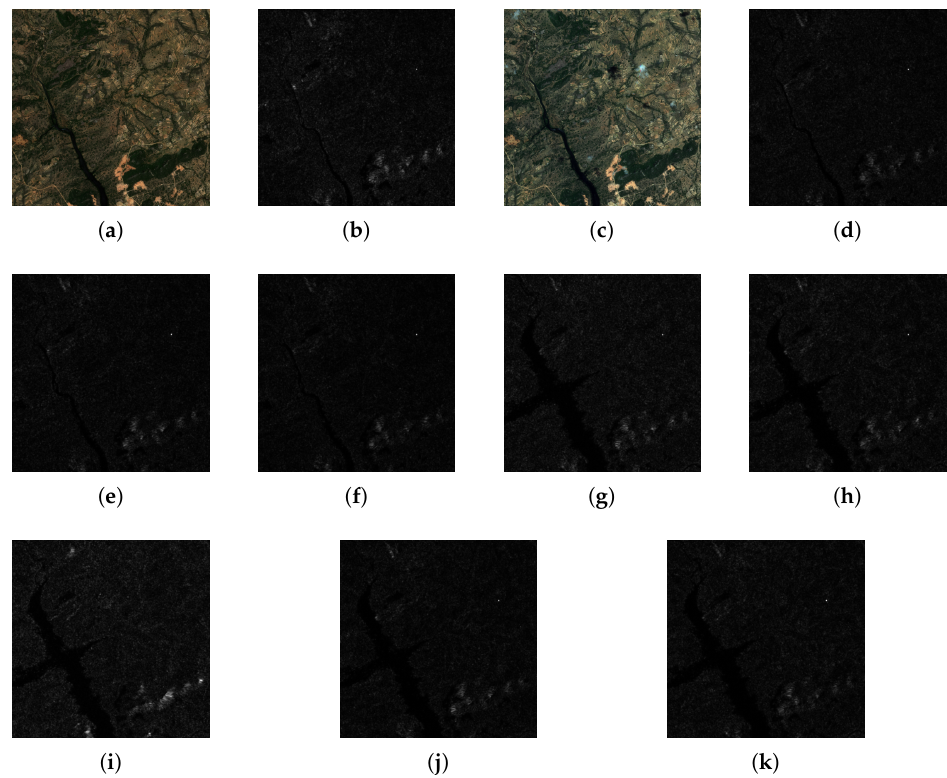
Figure 2. Mixed Sentinel-1 and Sentinel-2 SITS for flood detection: ( a ) 1 February 2019 (Sentinel-2), ( b ) 4 February 2019 (Sentinel-1), ( c ) 11 February 2019 (Sentinel-2), ( d ) 16 February 2019 (Sentinel-1), ( e ) 28 February 2019 (Sentinel-1), ( f ) 12 March 2019 (Sentinel-1), ( g ) 18 March 2019 (Sentinel-1), ( h ) 24 March 2019 (Sentinel-1), ( i ) 30 March 2019 (Sentinel-1), ( j ) 5 April 2019 (Sentinel-1), ( k ) 17 April 2019